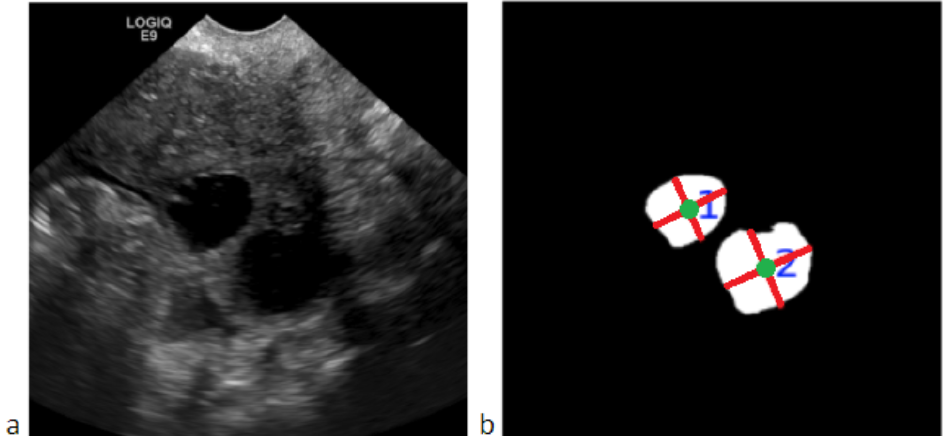
Figure 4. ( a ) shows an ovarian US image with two oval-shaped follicles; ( b ) shows the corresponding follicle segmentation mask. The follicle delineations are white with green dots denoting individual follicles’ centroids. These act as the starting point for calculating the major and minor axis lengths shown in red lines. The diameter is then calculated by multiplying the axis lengths by the pixel size in mm to obtain physical measurements. The follicle count is labeled in